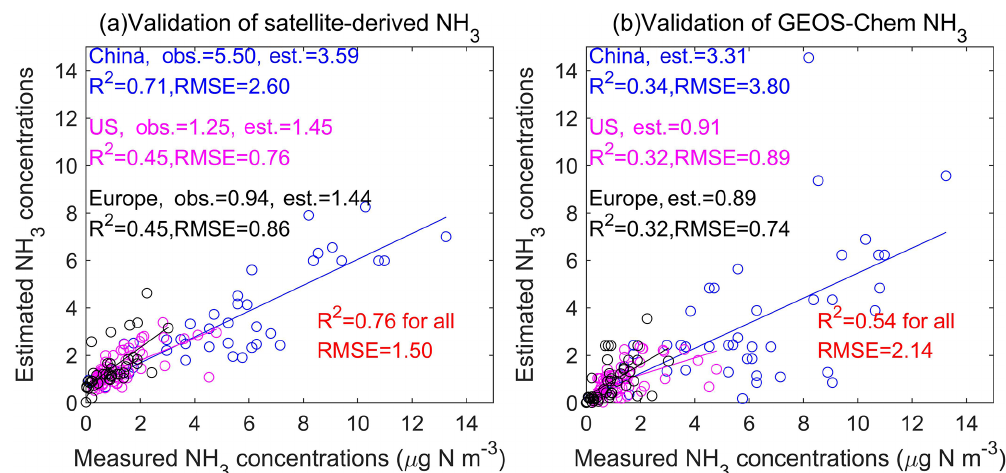
Figure 10. Comparison between yearly satellite-based and measured surface NH 3 concentrations (a) and comparison between yearly mod- eling (by an ACTM as GEOS-Chem) and measured surface NH 3 concentrations (b) (Liu et al., 2019). The ground-based monitoring sites are shown in Fig. 4.